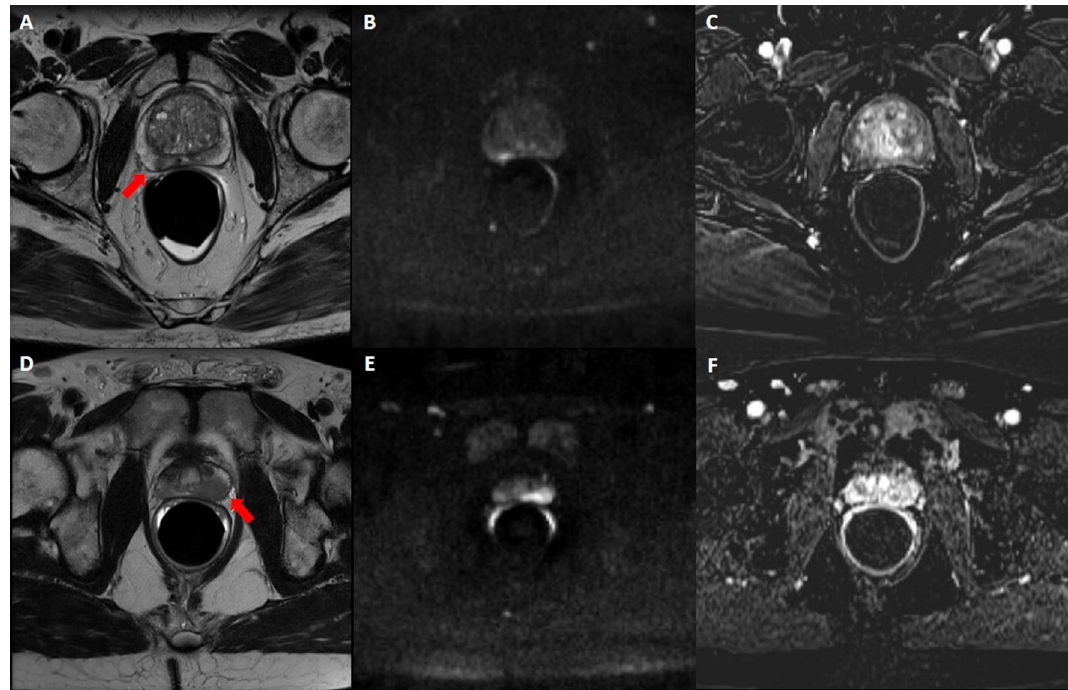
Figure 3. upPI-RADS 4 scored alterations. In the first row, an example of upPI-RADS 4 lesion confirmed at biopsy as GS 4 + 4: mpMRI showed reduced T2 signal intensity in the right PZ ( A ), altered diffusivity at b1000 DWI ( B ) with focal contrast enhancement ( C ). In the second row, an example of upPI-RADS 4 lesion classified as inflammatory at biopsy: mpMRI showed reduced T2 signal intensity in the right PZ ( D ), altered diffusivity at